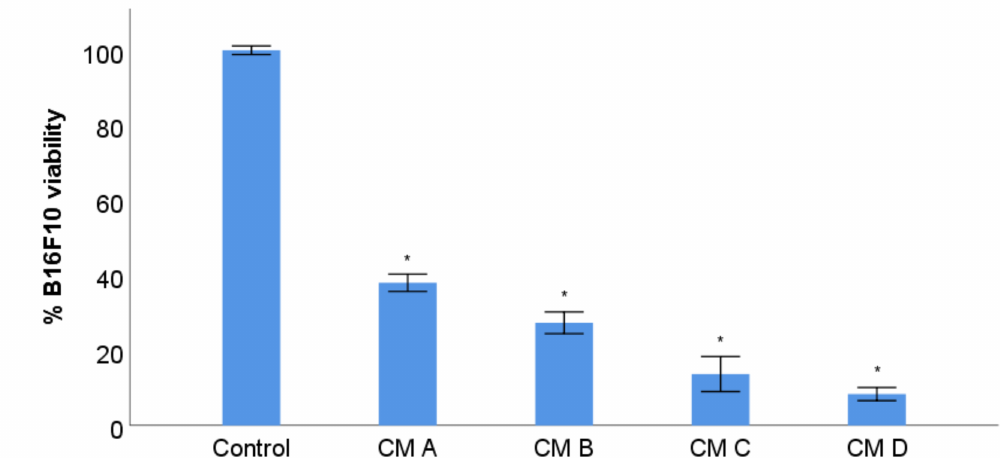
Figure 6. B16F10 viability study with CM from stimulation of RAW 264.7 with XN-loaded PLGA nanoparticles and XN solubilized form. The control refers to B16F10 incubated with DMEM. B16F10 cells treated with: CM from RAW 264.7 incubated with DMEM (A), CM from RAW 264.7 incubated with XN solution 14 µ M (B), CM from RAW 264.7 incubated with XN-loaded PLGA nanoparticles (C), CM from RAW 264.7 incubated with PLGA nanoparticles (D). B16F10 viability is expressed in mean percentage ± S.E.M.( n = 3 for each treatment assay). The experiment was repeated three times. * p < 0.050 in comparison with the